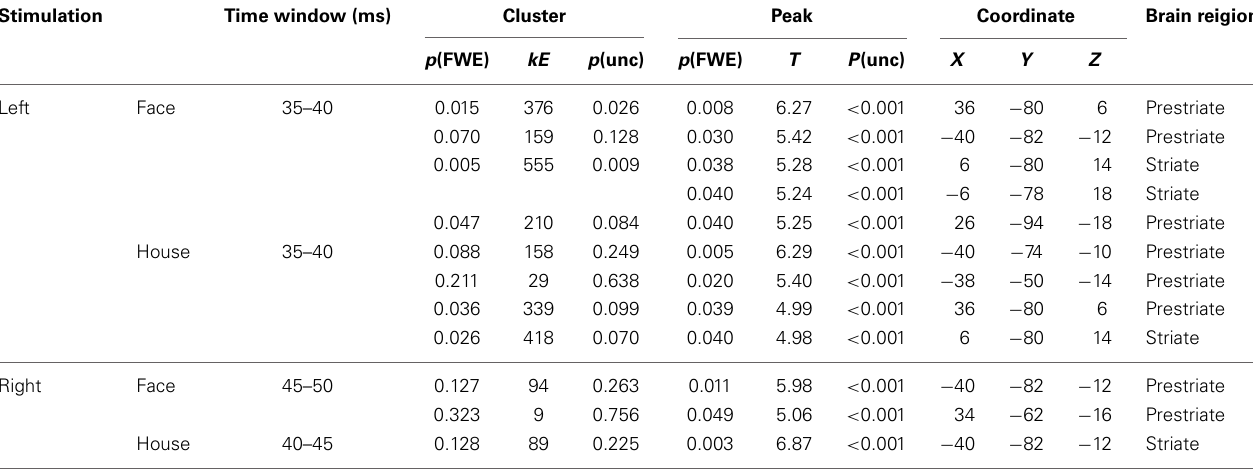
Statistical values, Cluster size, Location, MNI co-ordinates are displayed. In this table, all sources are peak level significant at p < 0.05 (FWE corrected).